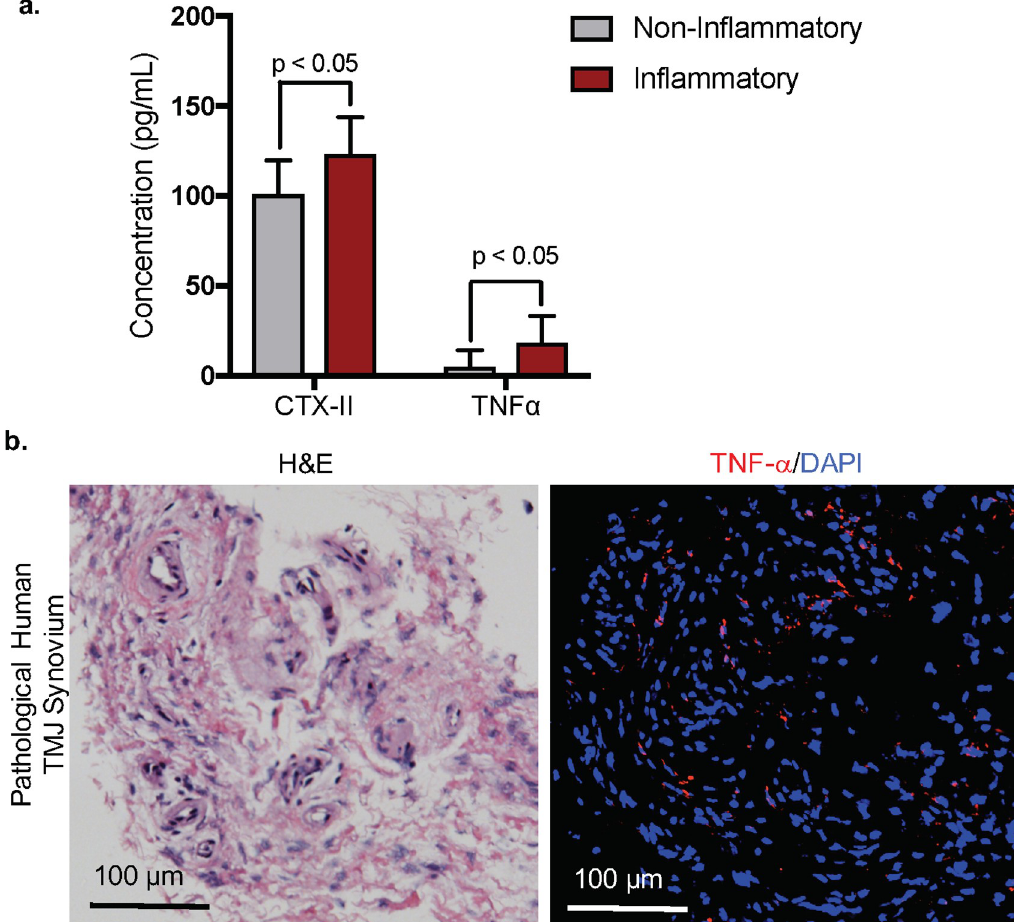
Fig 1. Synovial fluid and tissue derived from humans with inflammatory TMJ pathology have high CTXII and TNF-alpha levels. (a) ELISA was used to measure CTX-II, a type II collagen telopeptide as a biomarker for degradation, in synovial fluid derived from patients undergoing TMJ treatment. Patients with inflammatory TMJ pathology (n = 12; inclusion criteria included synovitis, osteoarthritis, and capsulitis) were included as ‘inflammatory’ and patients diagnosed with non- inflammatory TMJ pathology (n = 7; contusion, chronic dislocations, TMJ pain dysfunction syndrome, and disc displacement/ internal derangement without associating synovitis) were labeled as ‘non-inflammatory.’ Data are mean ± SD; n = 2 technical replicates. � p < 0.05, ordinary one-way ANOVA. (b) ELISA was used to measure TNF-alpha, an inflammatory mediator of joint arthritis, in synovial fluid derived from patients undergoing TMJ therapy. Patients identified with inflamed TMJ tissue (n = 12; inclusion criteria included synovitis, osteoarthritis, and capsulitis) were categorized as ‘inflammatory’ and patients with non- inflammatory TMJ pathology (n = 7; contusion, chronic dislocations, TMJ pain dysfunction syndrome, and disc displacement/ internal derangement without associating synovitis) were categorized as ‘non-inflammatory.’ Data are mean ± SD; n = 2 replicates; � p < 0.05, ordinary one-way ANOVA. (c) H&E tissue section of human TMJ synovial tissue from a patient diagnosed with TMJ synovitis (left). Immunohistochemistry confirmed that TNF-alpha (red) was expressed in inflamed human TMJ synovium tissue (right). Isotype-matched negative control antibodies were used under the same conditions. Scale bar = 100 μ m. (Table 1). Due to the difficulty of acquiring TMJ synovial fluid from a healthy human TMJ, we compared CTXII levels from patients presenting with inflammatory TMJ pathology (n = 12; inclusion criteria included synovitis, osteoarthritis, and capsulitis) to patients presenting with non-inflammatory TMJ pathology (n = 7; contusion, chronic dislocations, TMJ pain dysfunc- tion syndrome, and disc displacement/internal derangement without associating synovitis). Relative to patients with pathology categorized as non-inflammatory, patients with pathology categorized as inflammatory showed elevated CTXII levels suggesting increased type II